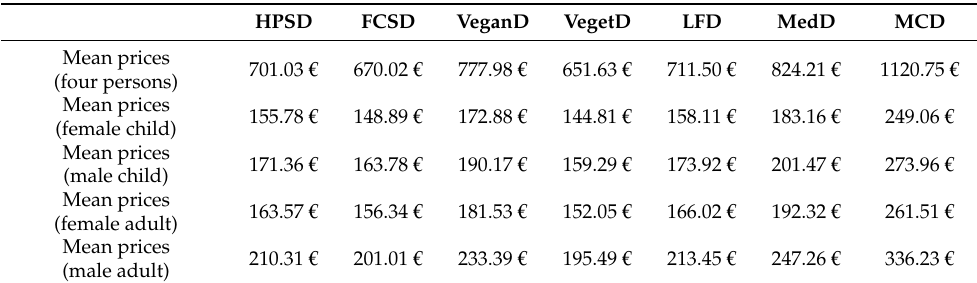
Table 4. Average grocery prices by